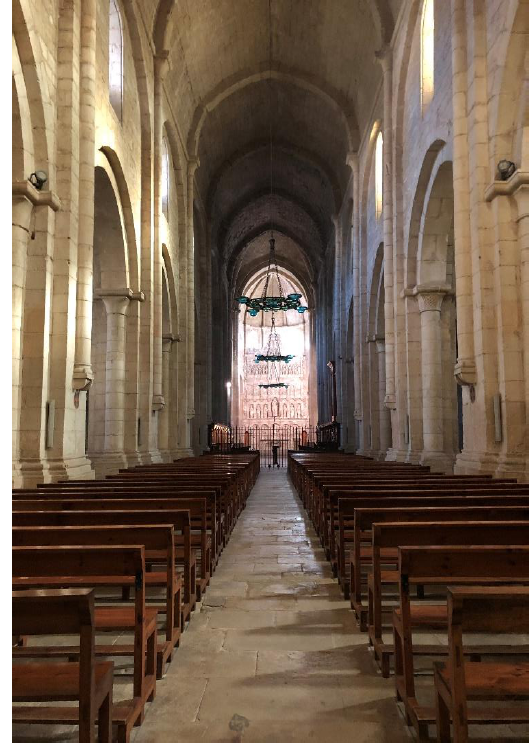
Figure 28. Immeasurable God of Poblet Monastery.